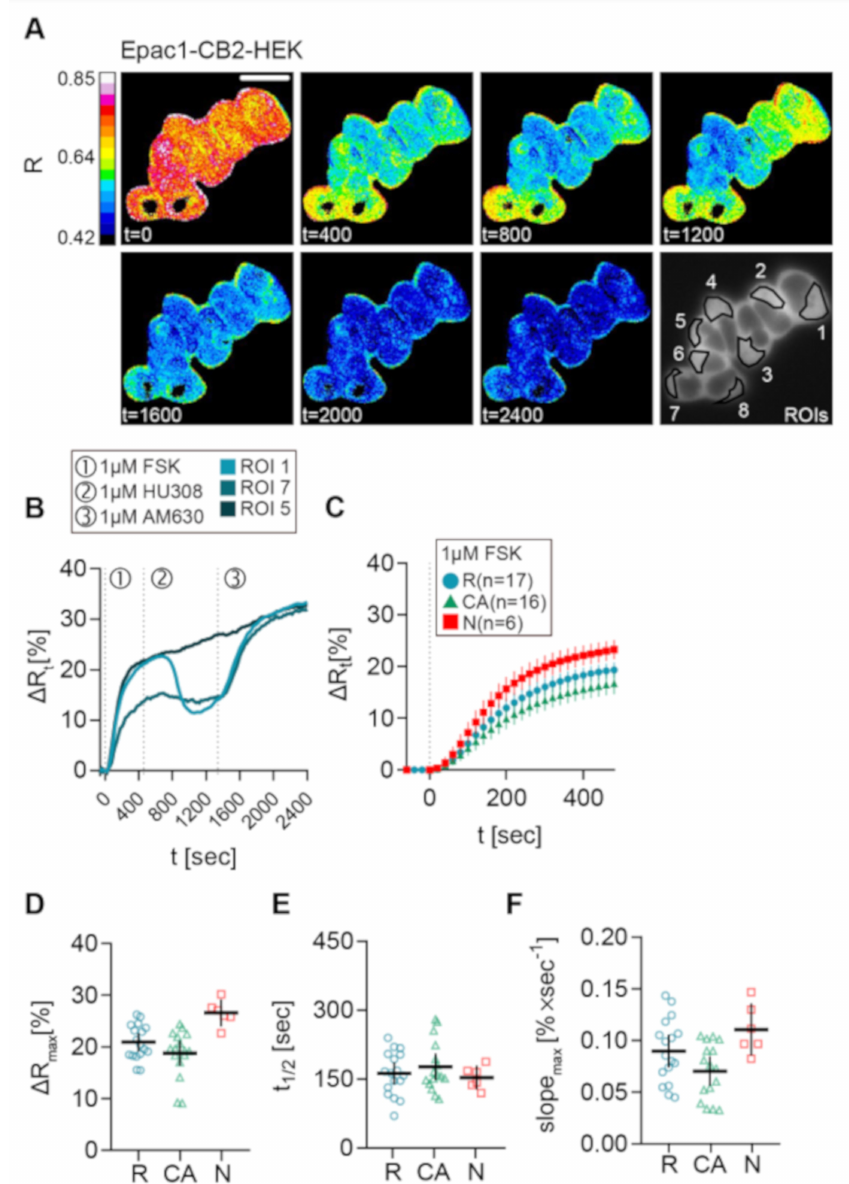
Figure 4. FSK response of di ff erent CB2 response types in Epac1-CB2-HEK cells. ( A ) Representative FRET ratio (R) images at di ff erent time points (t in seconds) and corresponding single cell FRET ratio ( ∆ Rt) ( B ) traces from indicated cells stimulated with 1 µ M FSK (1), 1 µ M CB2 agonist HU308 (2) and 1 µ M AM630 (3) showing the three response types R (ROI 1), CA (ROI 7), and N (ROI 5). ( C ) Mean ± 95%CI ∆ Rt FRET ratio traces showing the first 480 sec after FSK stimulation of the di ff erent Epac1-CB2-HEK response types. ( D ) Maximum peak ∆ R, ( E ) t1 / 2 and ( F ) max. slope values of FRET responses to FSK (arrow represents slope direction) of the di ff erent Epac1-CB2-HEK response types. Each data point n in D, E, and, F represents the average of all cells in one recording / coverslip with at least three cells of a response type. Type R n = 17, Type CA n = 16, Type N n = 6. Mean ± 95%CI. Scale bar = 20 µ